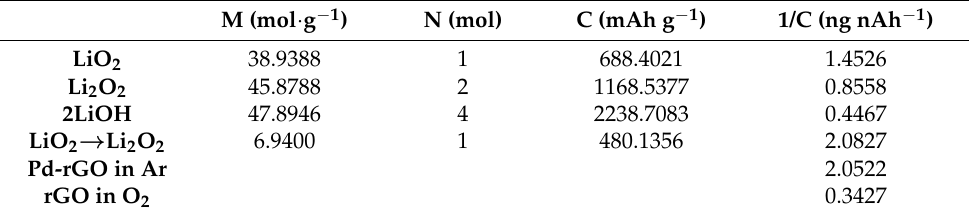
Table 2. The EQCM experimental matrix of different products.